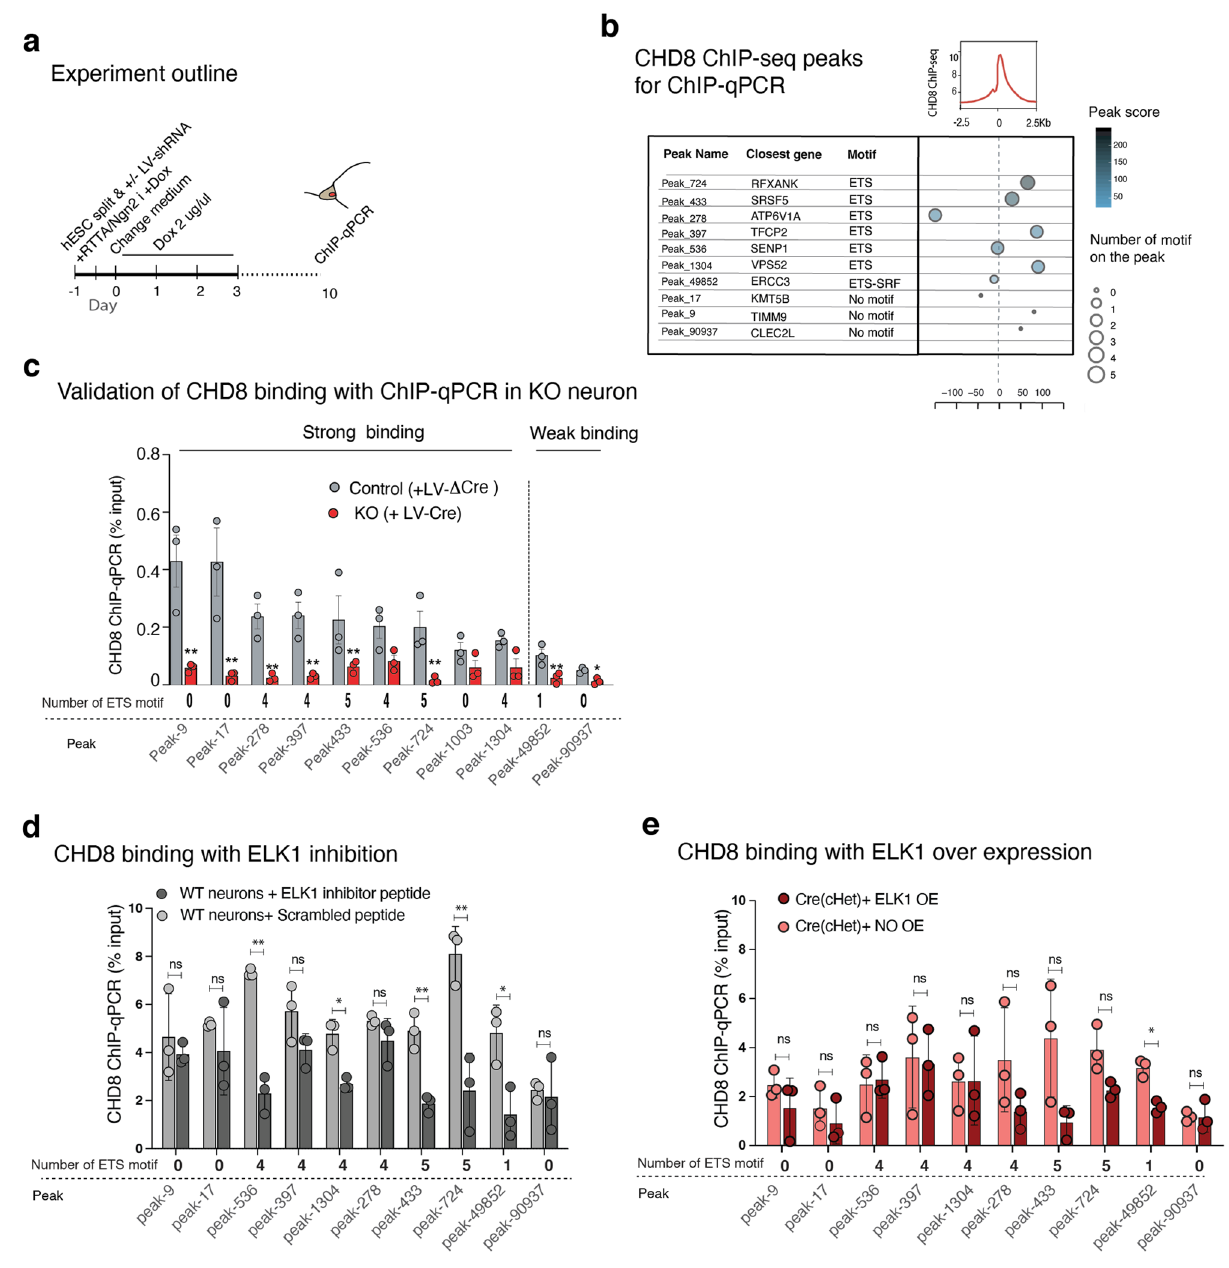
Figure 25. ELK1 perturbations and measurements of CHD8 binding to validated ChIP peaks. ( a ) Schematic depicts experiment outline and the timing of lentivirus-shRNA infection, dox treatment, and ChIP-qPCR experiment. ( b ) Table of selected CHD8 ChIP-seq peaks for ChIP-qPCR assessment; the number of motifs, peak score, and the location of each peak relative to TSS is shown. ( c ) ChIP-qPCR experiment to measure CHD8 binding on CHD8 ChIP-seq peaks in CHD8 knockout neurons. This experiment explicitly validates our ChIP-Seq results for CHD8 binding and provides good sites for downstream assays. ( d ) ChIP-qPCR for CHD8 binding with ELK1 inhibition in wild-type neurons. ( e ) ChIP-qPCR for CHD8 binding with ELK1 overexpression in CHD8 heterozygous knockout neurons (both red and pink barographs are